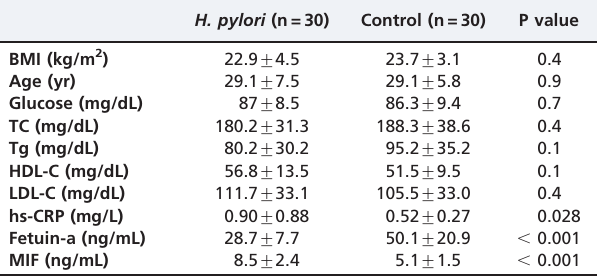
Table 1 - Clinical and laboratory characteristics of patients with H. pylori vs. control subjects. Results are presented as means ¡ SD.